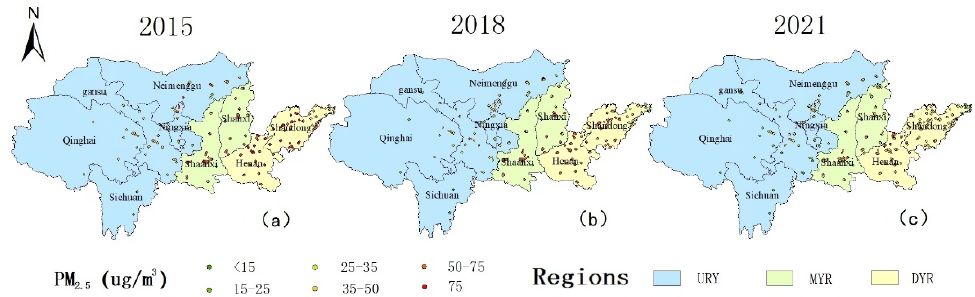
Figure 4. Spatial distribution of PM2.5 annual average concentrations in the Yellow River Basin from 2015 to 2021 ( a – c ). (UYR denotes the Upper Yellow River Basin, MYR denotes the Middle Yellow River Basin, and DYR denotes the downstream area of the Yellow River Basin.)